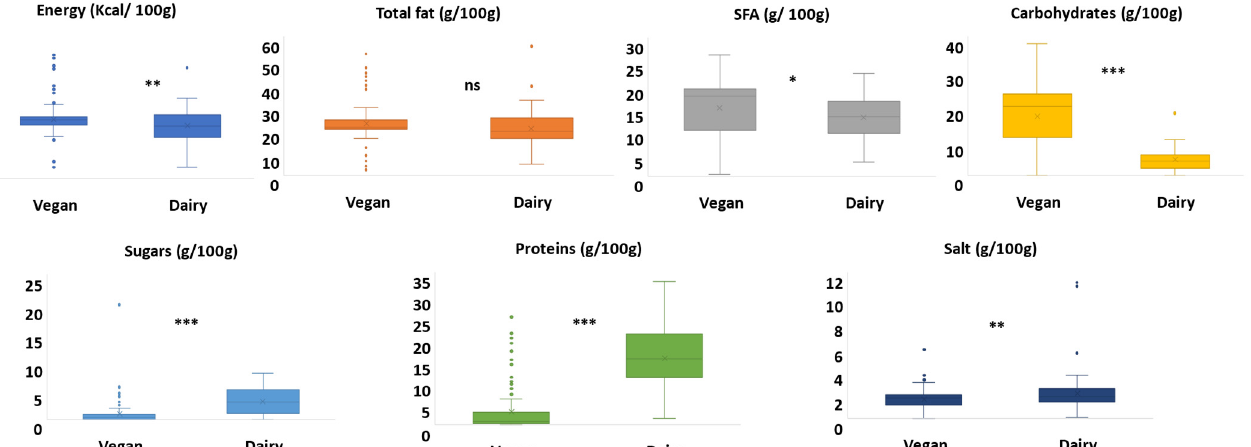
Table 3. Main ingredients of processed cheese.